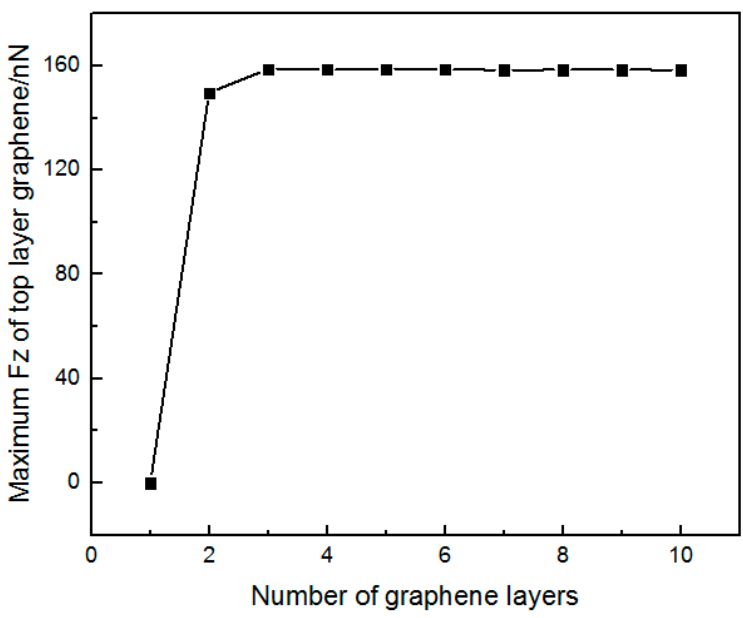
Figure 16. The maximum force to exfoliate the topmost layer. The work to exfoliate the topmost layer graphene in two to ten layers systems increases 10 3 to 10 4 times than that to exfoliate all layers. In the two-layer graphene system, the work to exfoliate the topmost layer is 136.79 mJ/m 2 shown in Figure 17, the average adhesion energy in three to ten layers graphene systems is 149.26 mJ/m 2 , consistent with the results in the literature [24]. Because of Van der Waals, it is difficult to exfoliate the topmost layers of graphene, reflecting the difficulty of fabricating monolayer